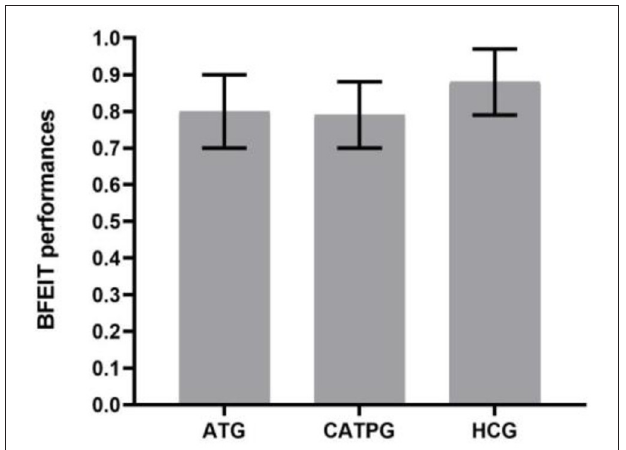
FIGURE 2 | Comparisons of BFEIT performance among the AT group, CATP group, and HC group. BFEIT, basic facial emotion identification test; ATG, antidepressant treatment group; CATPG, the combination of antidepressant treatment and PST group; HC, healthy control; SD, standard deviation.